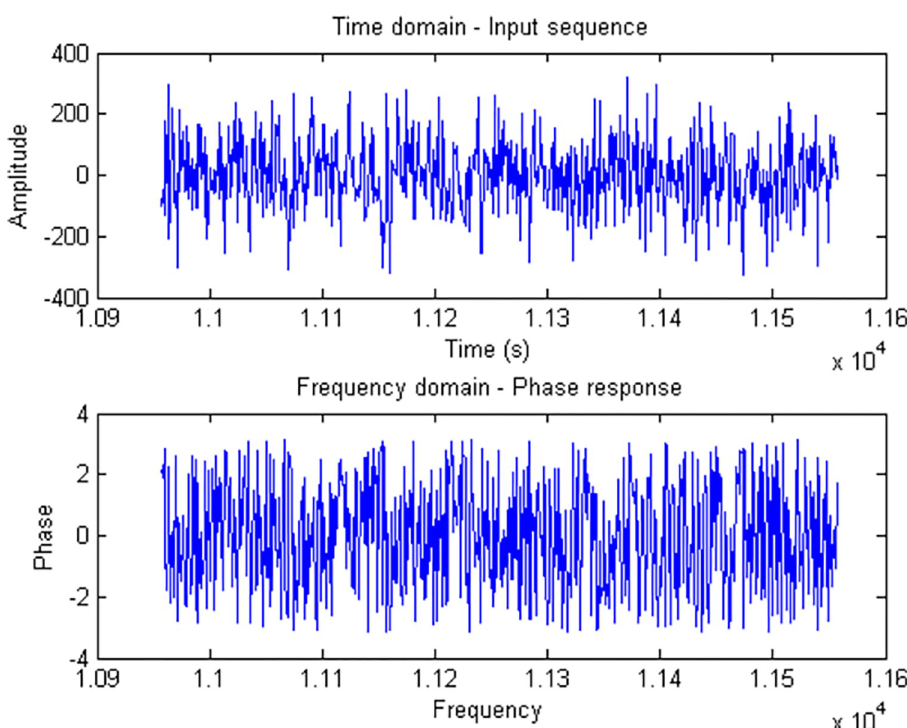
Fig 1. Comparison of sequence similarity from Fourier frequency domain for all 30 genes.